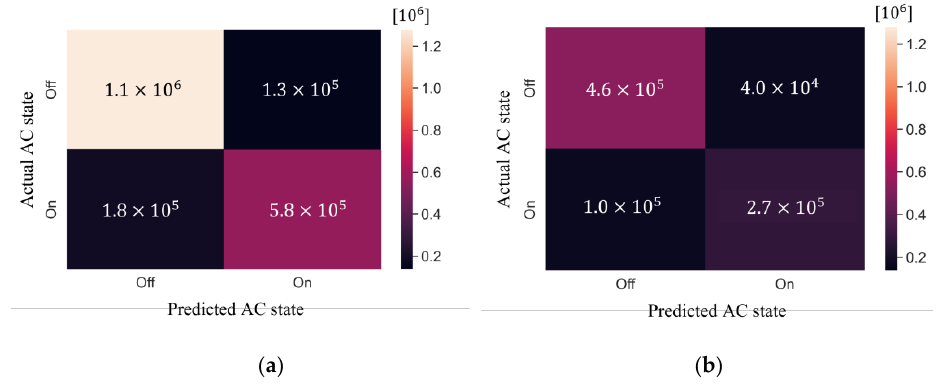
Figure 12. Confusion matrix of XGBoost model in ( a ) training group and ( b ) testing group. Table 6. Prediction performance of the model in both the training and testing group.